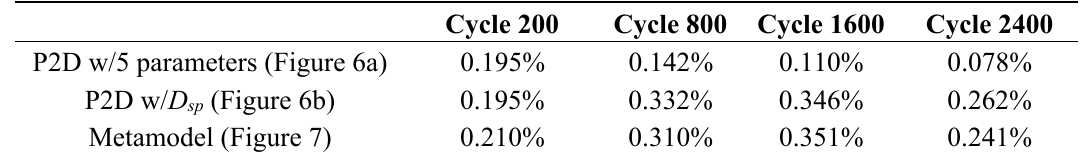
Table 2. Error e i of the model with respect to experimental data.